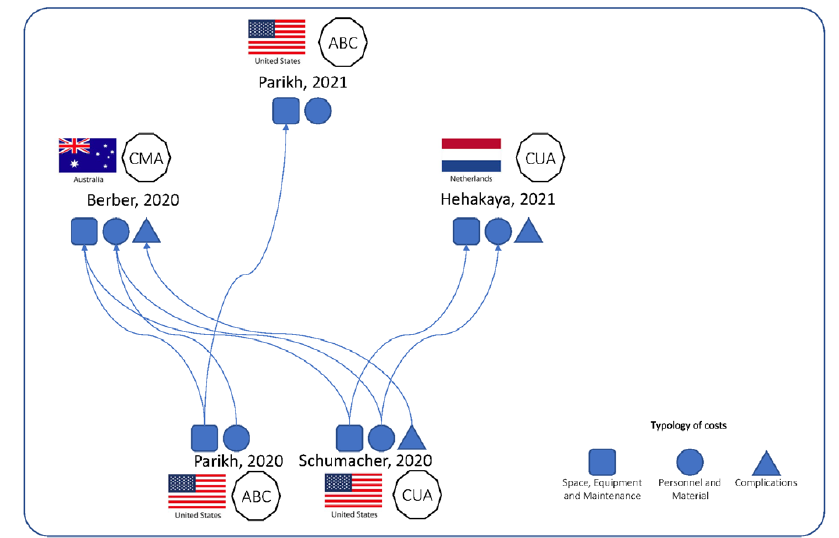
Figure 2. Graphical description of interrelations among studies